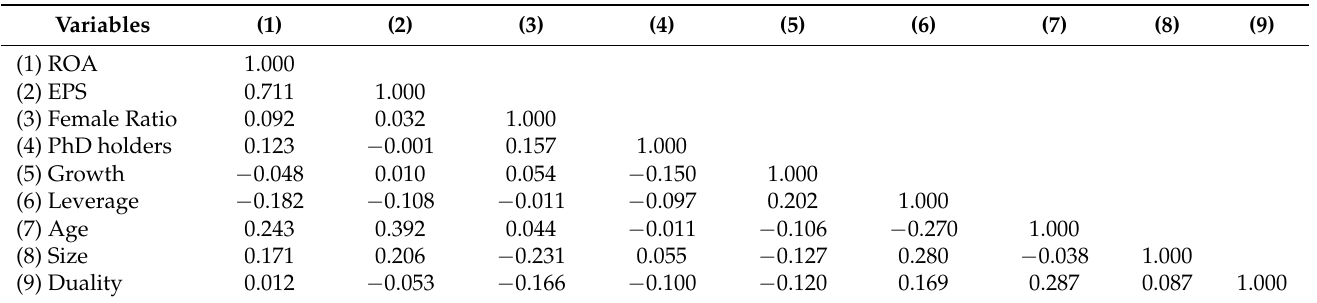
Table 3. Matrix of correlations.